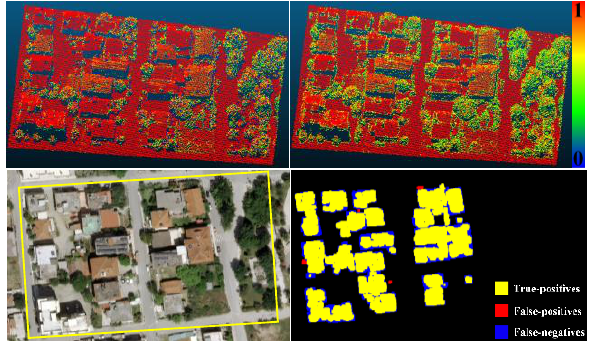
Figure 2. The LIDAR point cloud coloured by the initial N z values (top left); the filtered N z values by the scan line smooth filtering technique (top right); the orthoimage of the area of interest (bottom left) and the evaluation of the building detection results (bottom